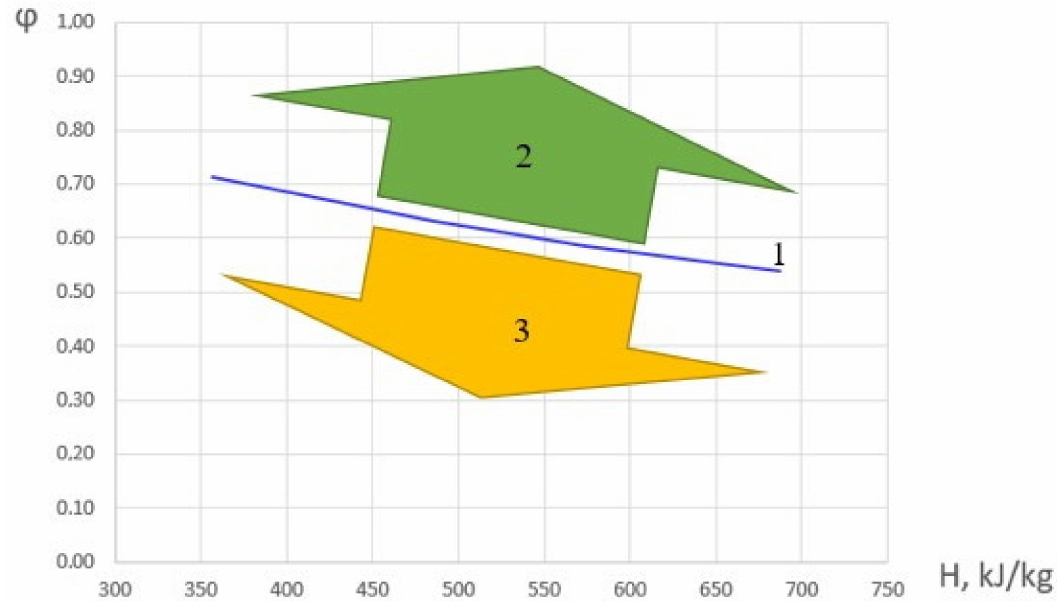
Figure 6. Dependence of the fuel excess coefficient, corresponding to ∂η / ∂ϕ = 0 on the initial HOF enthalpy (1), the area of the diffusion combustion mode (2), and the kinetic combustion mode